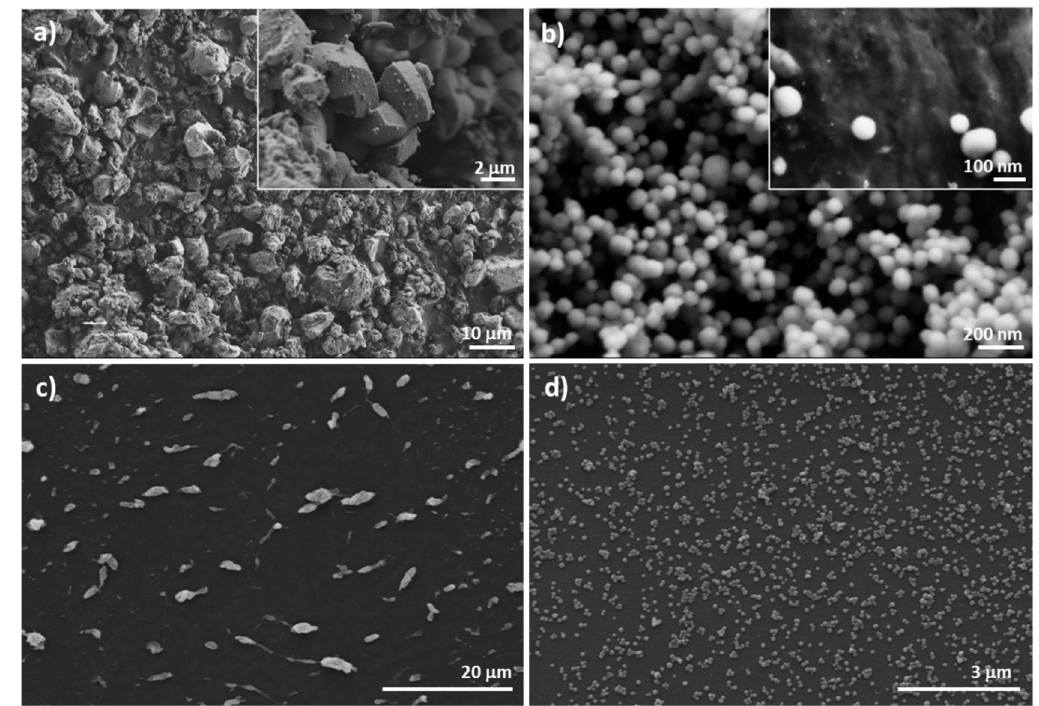
Figure 5. Representative field-emission SEM (FESEM) images of ( a ) M-Rh-N3 and ( b ) N-Rh-N3 particles, and ( c ) M-Rh-N3 and ( d ) N-Rh-N3 particles covalently anchored to EVOH 32 film after being UV-treated for 15 min.